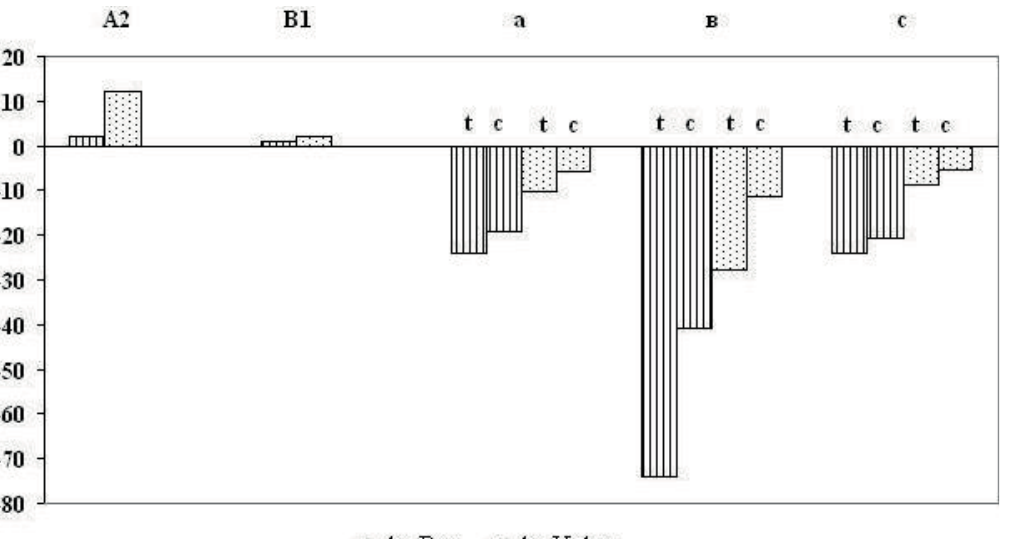
Fig. 2 Observed and expected future (2025–2030) water abstraction in the Don and Volga basins, and the projected change in their mean annual runoff in the first three decades of the 21st century with contrasting A2 and B1 scenarios of global climate warming (as a percentage of the mean annual runoff). t – total water withdrawal, c – consumptive water